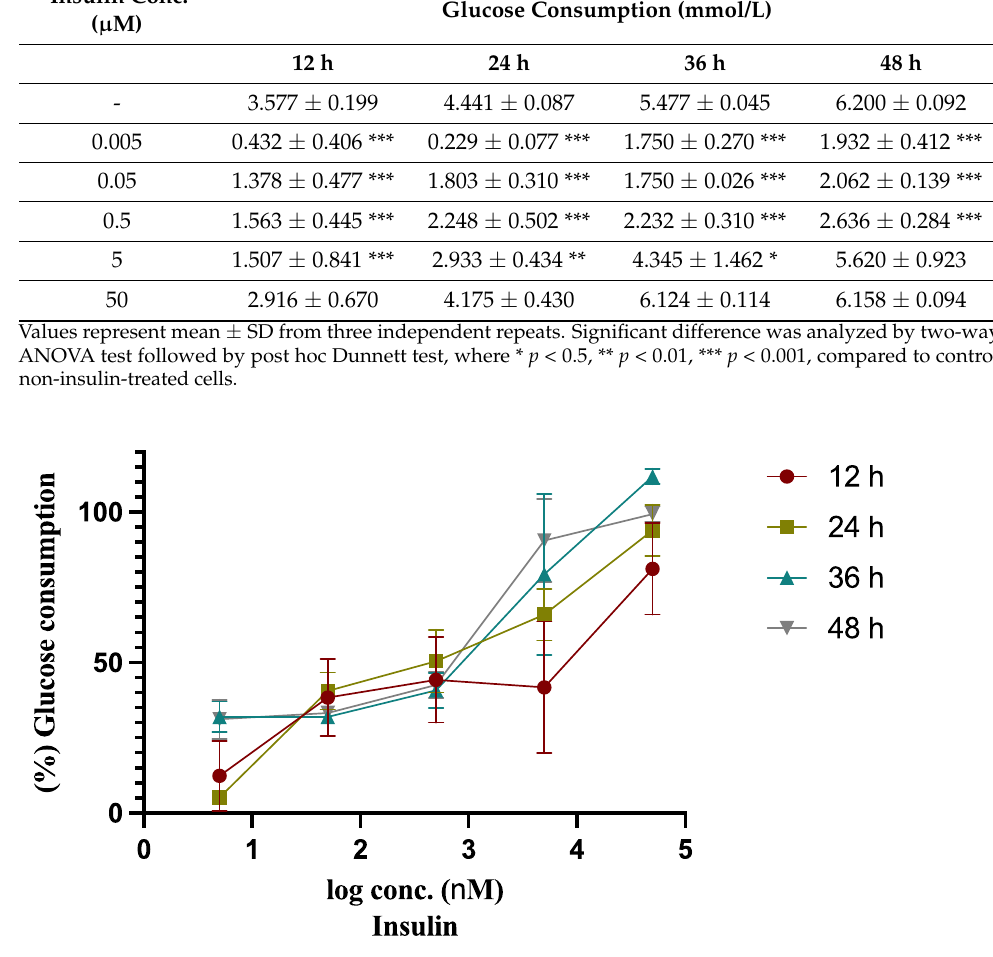
Figure 1. Establishment of insulin resistant model on HepG2 cells through examining the effect of